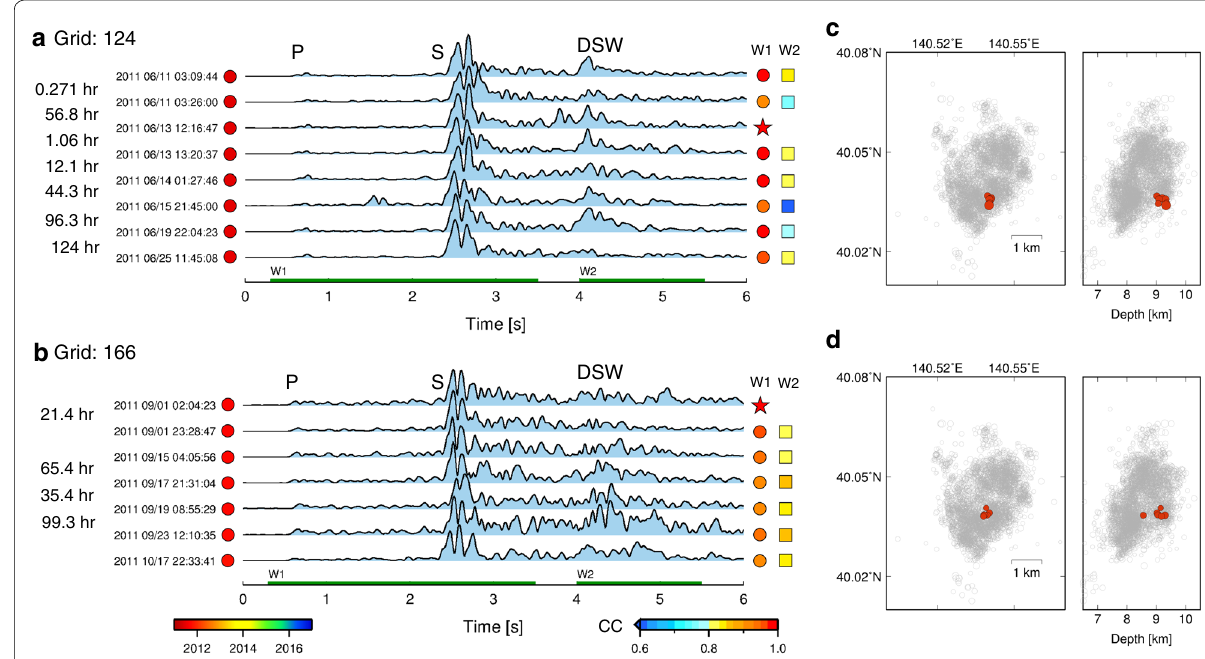
Fig. 6 Envelopes and hypocenter distribution of the two groups that showed short-term changes in the DSW part. a , b are the same as Fig. 4, but without the overwriting of envelopes. c , d are the relocated hypocenter distributions of the events in groups ( a ) and ( b ) (red solid circles). Gray circles denote hypocenter distribution of whole earthquakes